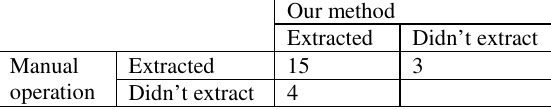
Table 2: Number of extracted polygons Our method Extracted Didn’t extract Extracted